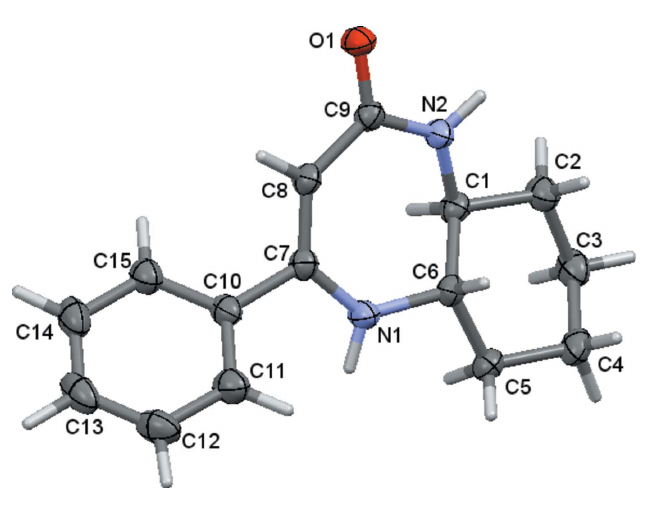
Figure 1 The title molecule, shown with 50% probability displacement ellipsoids. Only the major conformation is